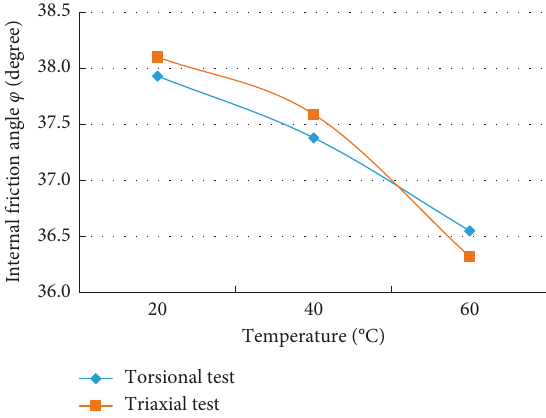
Figure 17: Distribution of the internal friction angle φ at different